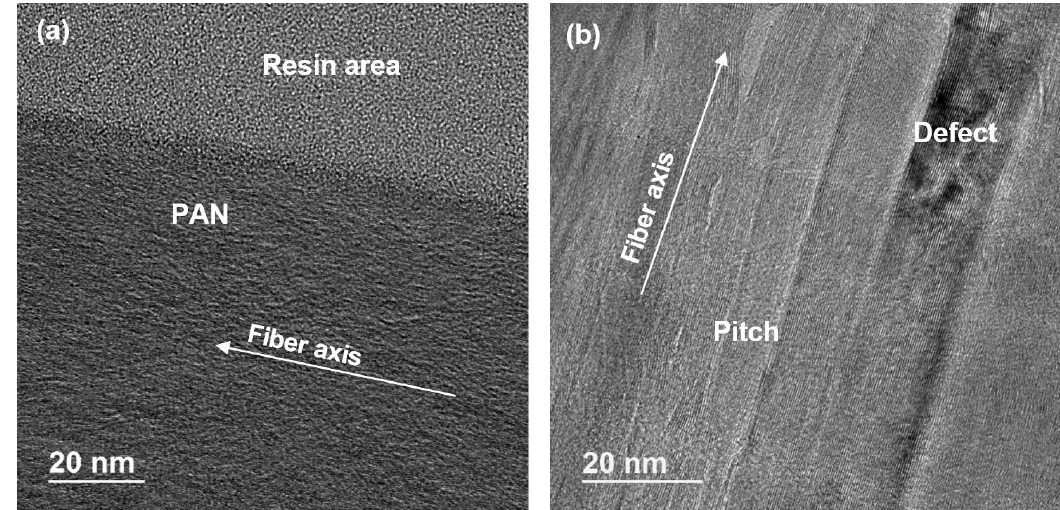
Figure 3. TEM images in the longitudinal direction of each fiber. ( a ) PAN-based CF; ( b ) Pitch-based CF with significantly longer and larger crystalline structures as compared with PAN.